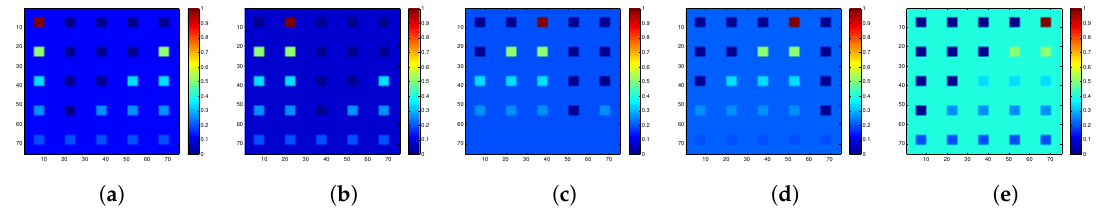
Figure 4. True abundance matrix of simulated data set 1 ( DS ). ( a ) Endmember 1; ( b ) Endmember 2; ( c ) Endmember 3; ( d ) Endmember 4; ( e ) Endmember 5.